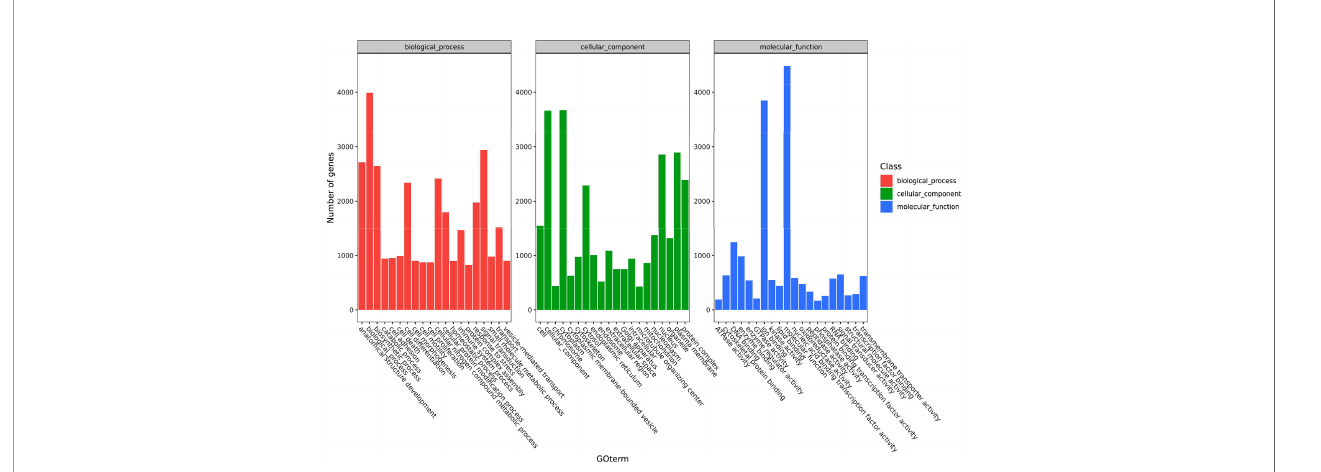
FIGURE 3 | A histogram of the enriched subcategories after GO annotation of DEGs in channel cat fi sh infected by bacteria. The GO terms (X-axis) were grouped into 3 main ontologies, including biological processes (BP), cellular components (CC) and molecular functions (MF). The Y-axis indicates the number of